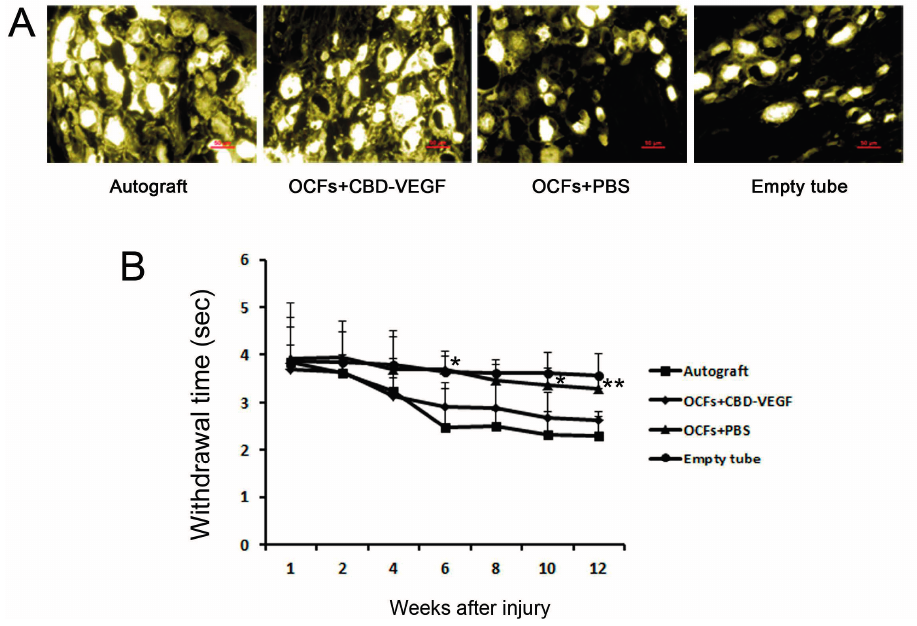
Figure 3. Sensory function and retrograde tracing test. ( A ) Fluorescent micrographs following FG retrograde tracing in the DRGs in the four groups 12 weeks after nerve grafting. n = 3. Scale bar, 50 µm; ( B ) Withdrawal time elicited by a hot water stimulus in each group. Data are expressed as mean ± SD, n = 5, * p < 0.05, ** p < 0.01, OCFs + CBD-VEGF group vs. OCFs + PBS